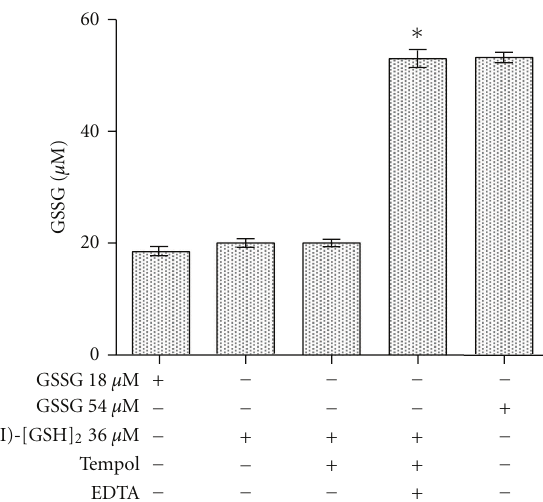
Figure 5: Recovery of GSSG from a Tempol-treated Cu(I)-[GSH] 2 complex using the EDTA-modified NADPH/glutathione reductase assay. GSSG was assessed applying the NADPH/glutathione reduc- tase assay to solutions containing pure GSSG (18 or 54 μ M), the Cu(I)-[GSH] 2 complex (36 μ M) or a Tempol-treated Cu(I)-[GSH] 2 complex (36 μ M). The assays were run both in the presence or in the absence of EDTA (2mM). Results are expressed as μ M GSSG concentration. The asterisk on the bars indicates that such values are statistically di ff erent, at the level of a P < 0 . 001, from all other